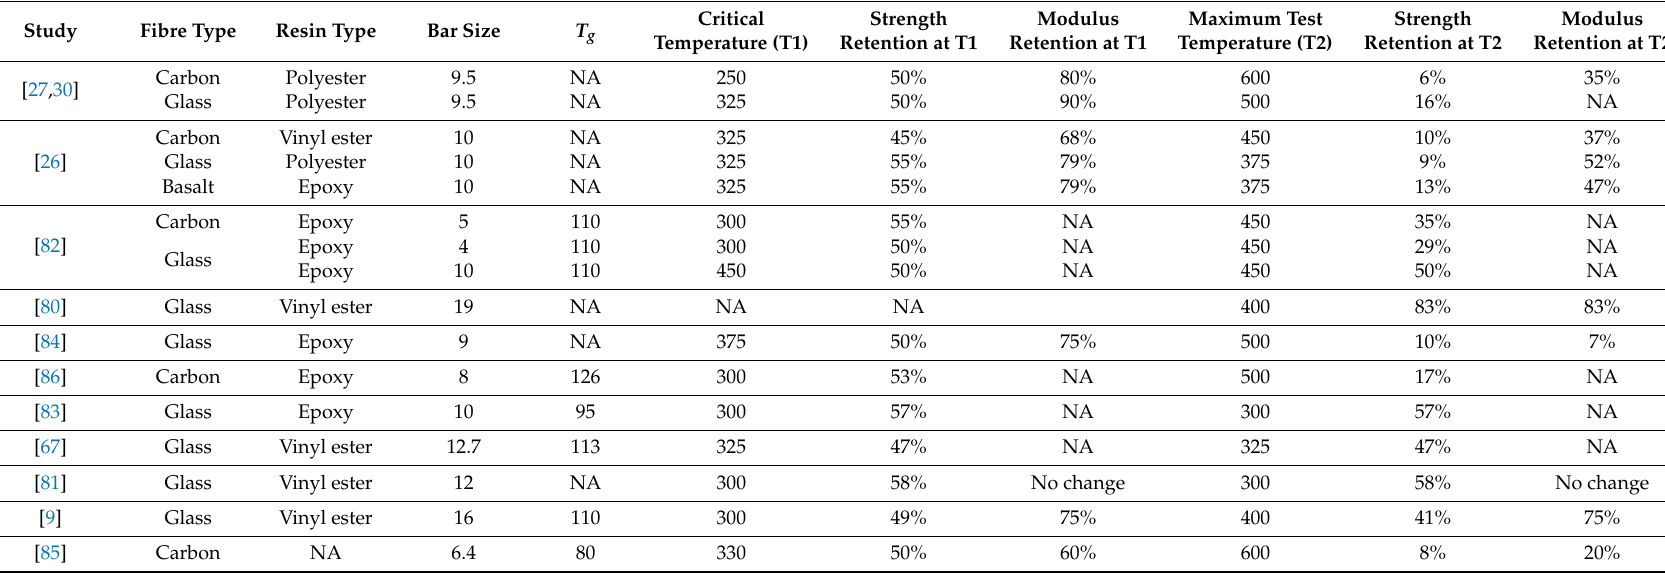
Table 1. FRP bars tensile properties after exposure to elevated temperatures (steady state tensile